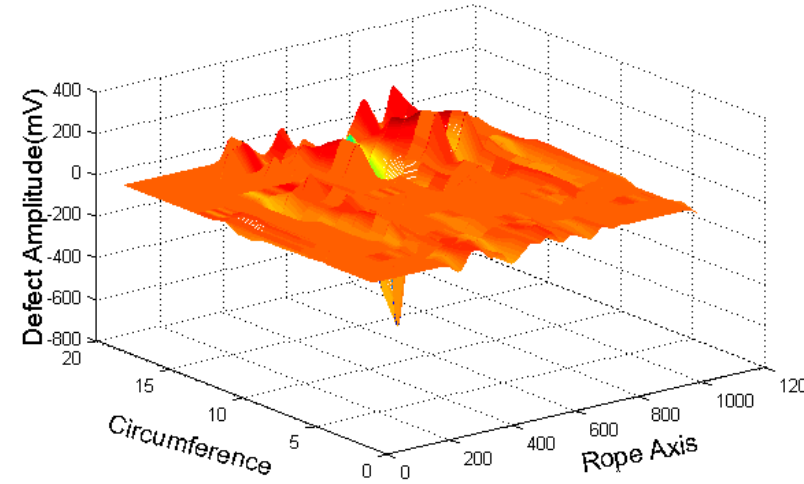
Figure 6. CSWF filtered three-dimensional diagram.